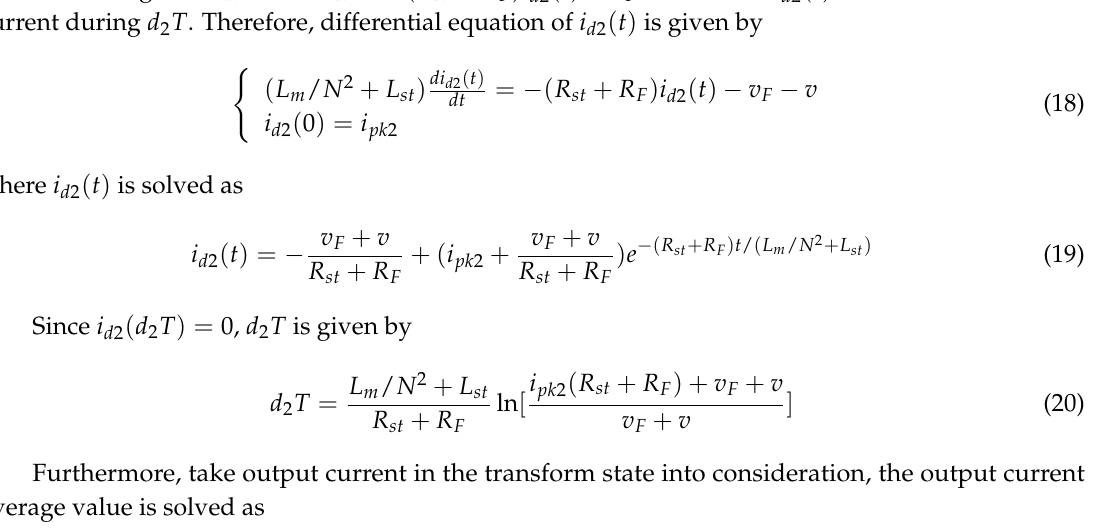
Figure 9. Flyback converter in switch-off state. ( a ) Active circuit, ( b ) Equivalent circuit scheme. The voltage on L m / N 2 + L st is − ( R st + R F ) i d 2 ( t ) − v F − v , where i d 2 ( t ) denotes the